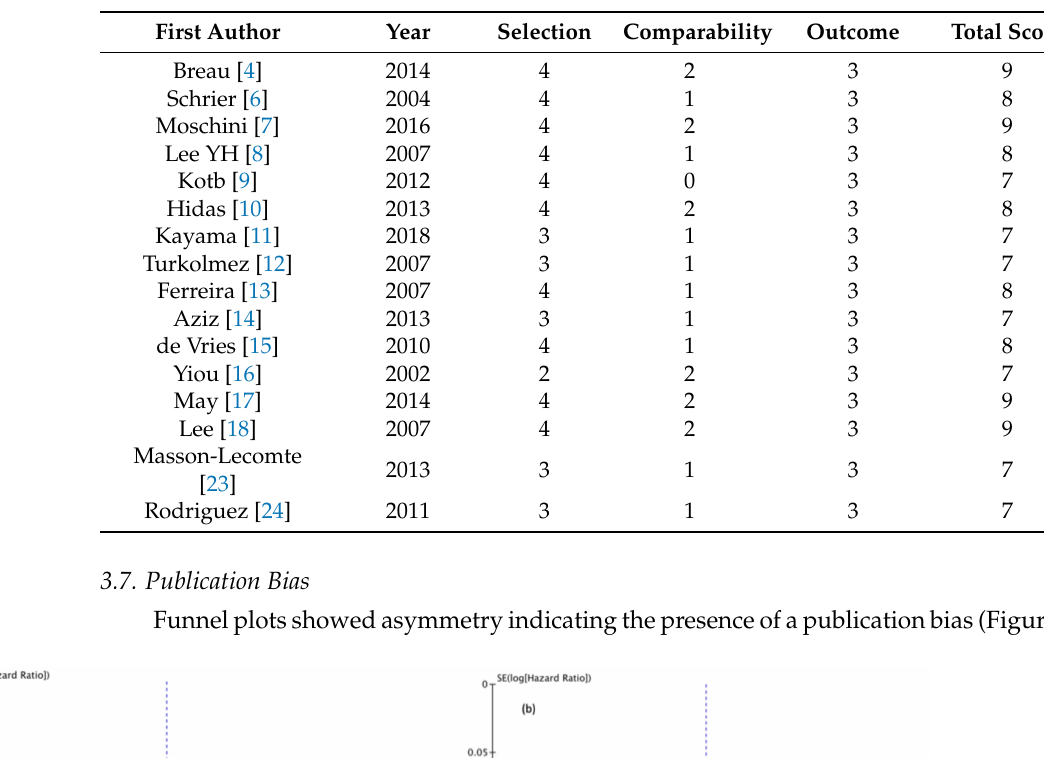
Table 3. Newcastle-Ottowa Scale quality assessment.